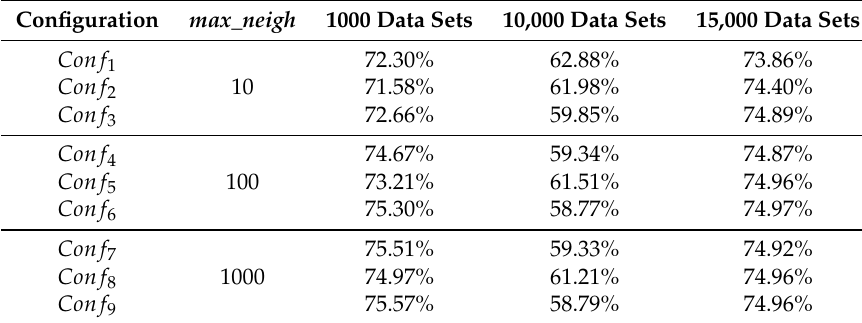
Figure 5. Average execution times for Step 4. Table 9. Fraction of average execution times for environment Env 1 ( Hadoop technology) with respect to no Map-Reduce